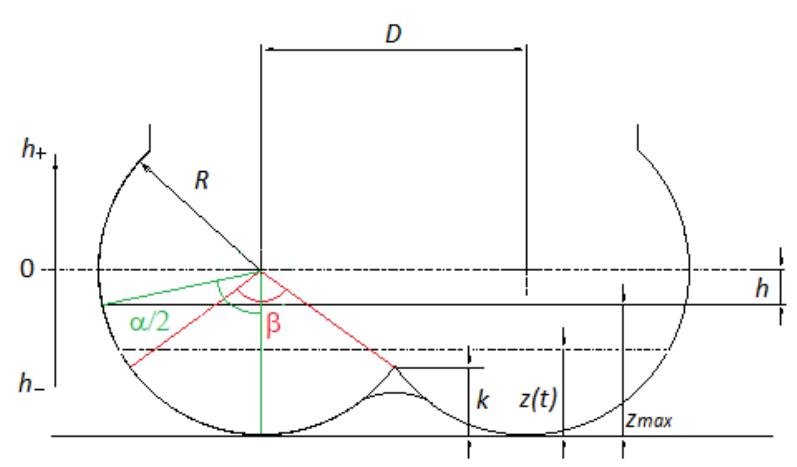
Figure 3. Omega tank and geometrical parameters.